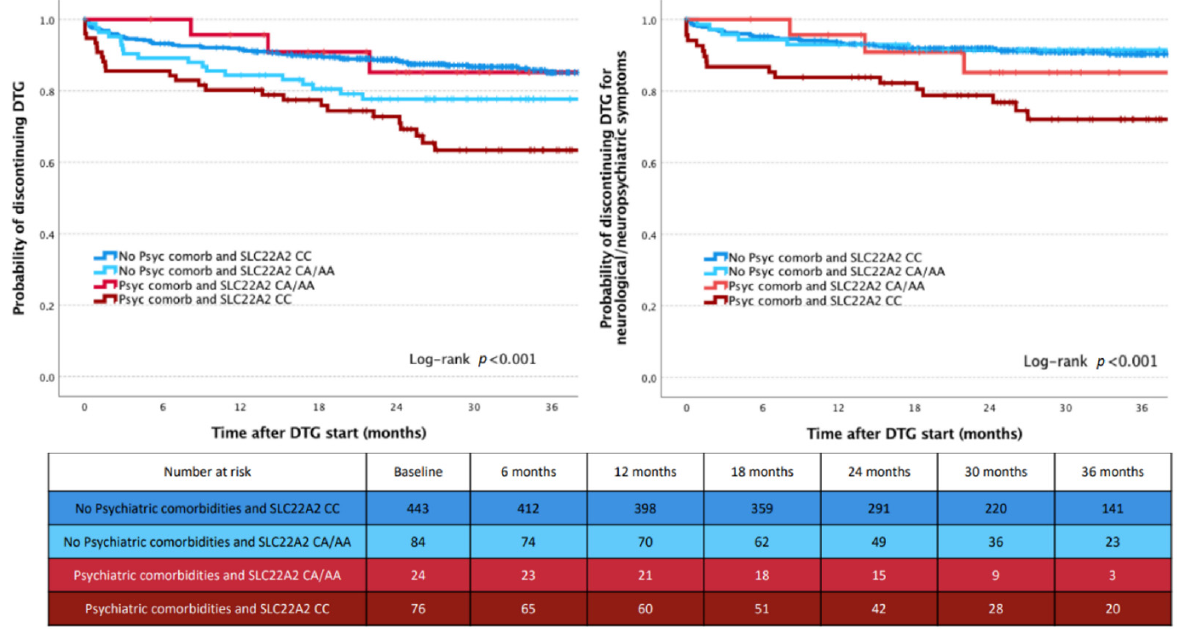
Figure 2. Risk of dolutegravir discontinuation for all causes ( left panel) and for neuropsychiatric symptoms ( right panel) according to the variable combining pre-existing psychiatric comorbidities and SLC22A2 variant. Metabolites 2022 , 12 , x FOR PEER REVIEW